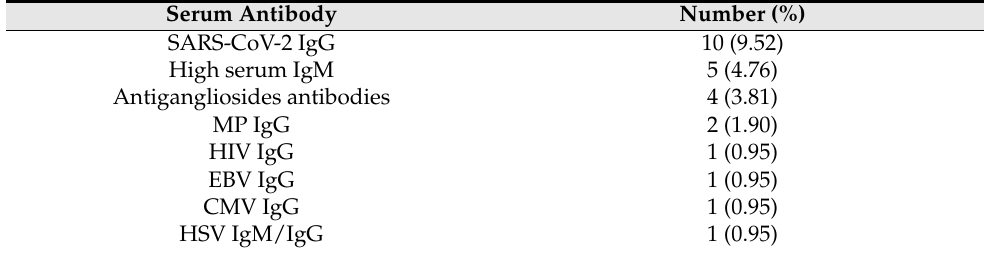
Table 7. Serum antibody